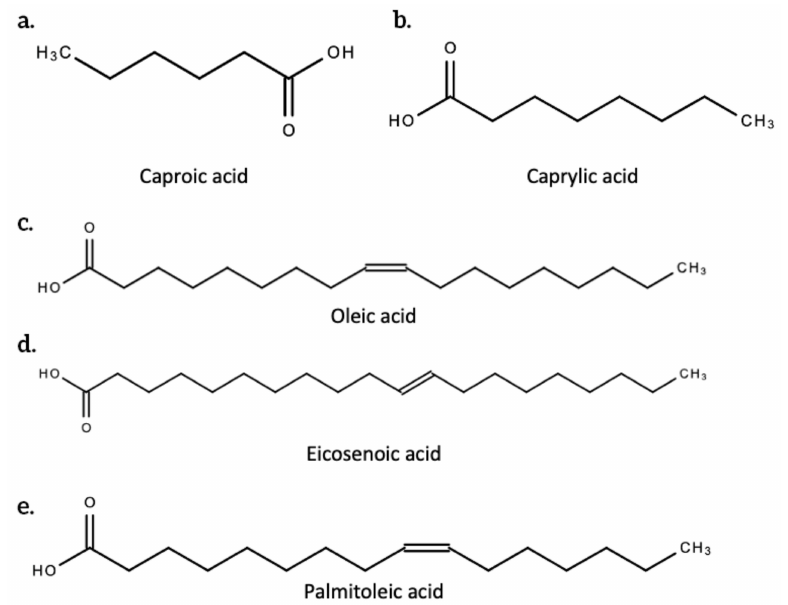
Figure 6. The structure of some fatty acids found in C. sativa L. [48]. ( a .) Caproic acid; ( b .) Caprylic acid; ( c .) Oleic acid; ( d .) Eicosenoic acid; ( e .) Palmitoleic acid.